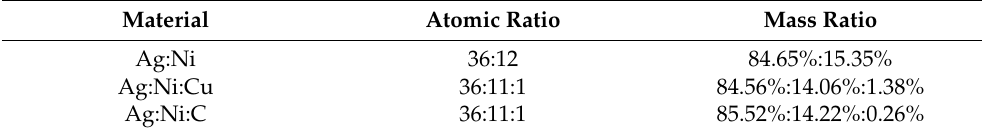
Table 1. Atomic ratio and mass